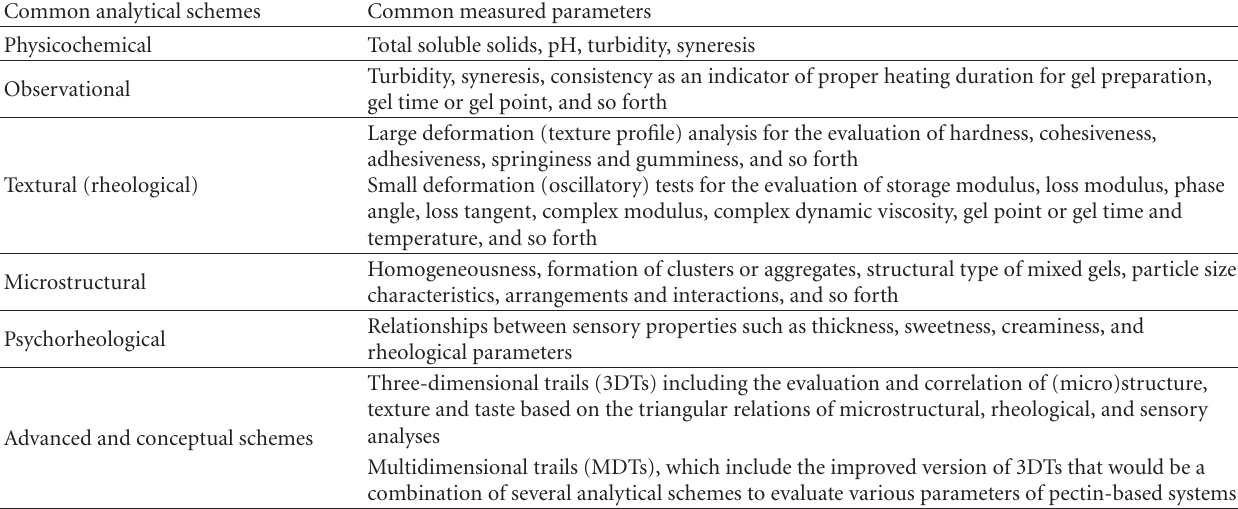
Table 1: An overview of the common, advanced, and conceptual analytical schemes discussed in this study for the characterization of pectin-based edible gel